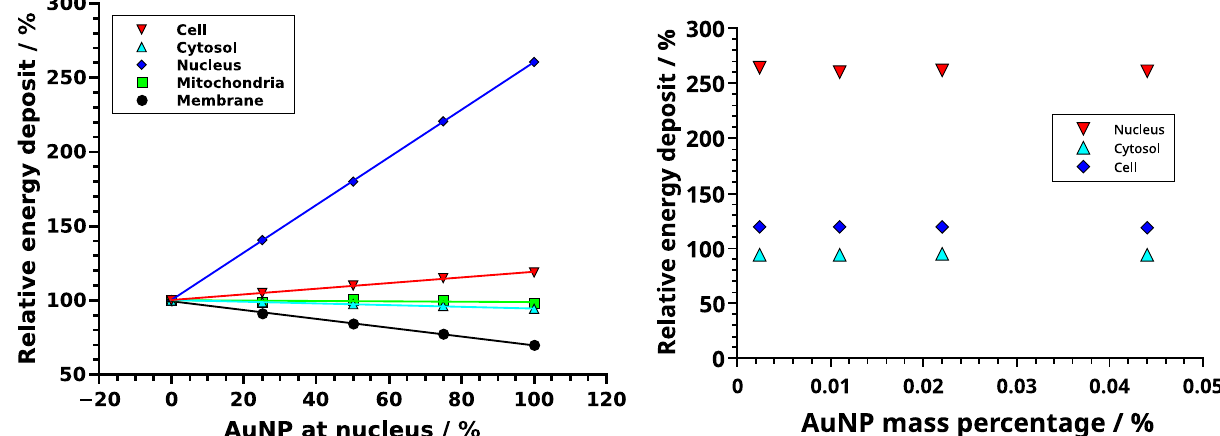
Figure 4. Left: Relative energy deposit ( E rel ( x ) = 100 % · E ( x )/ E ( 0 % ) ) in dependence of AuNP (r = 5 nm) located at the nucleus with respect to the case of all AuNP distributed randomly in the cytosol. The total amount of AuNP in the cell is constant (n = 10,000). The curves represent linear fits. Right: Relative energy deposit in the whole cell, cytosol and nucleus when all AuNP are located at the nucleus compared to randomly distributed AuNP for different mass percentages and radii. For details see the